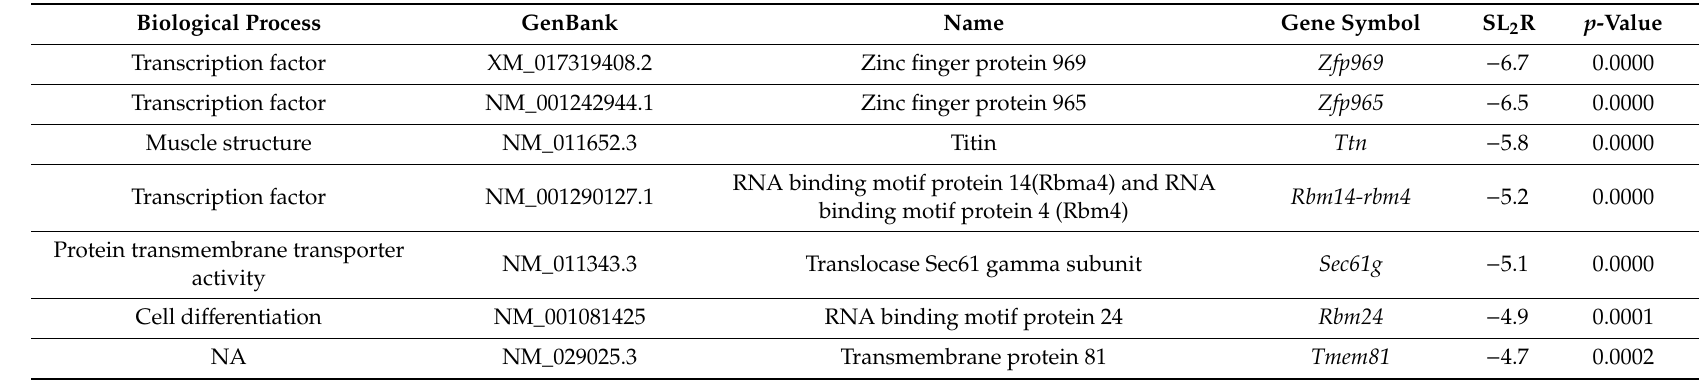
Table 2. Hepatic transcripts di ff erentially down-regulated by the administration of erythrodiol at the level of signal log 2 ratio < 1.5 and false discovery rate < 0.001 in male Apoe -deficient mice according to